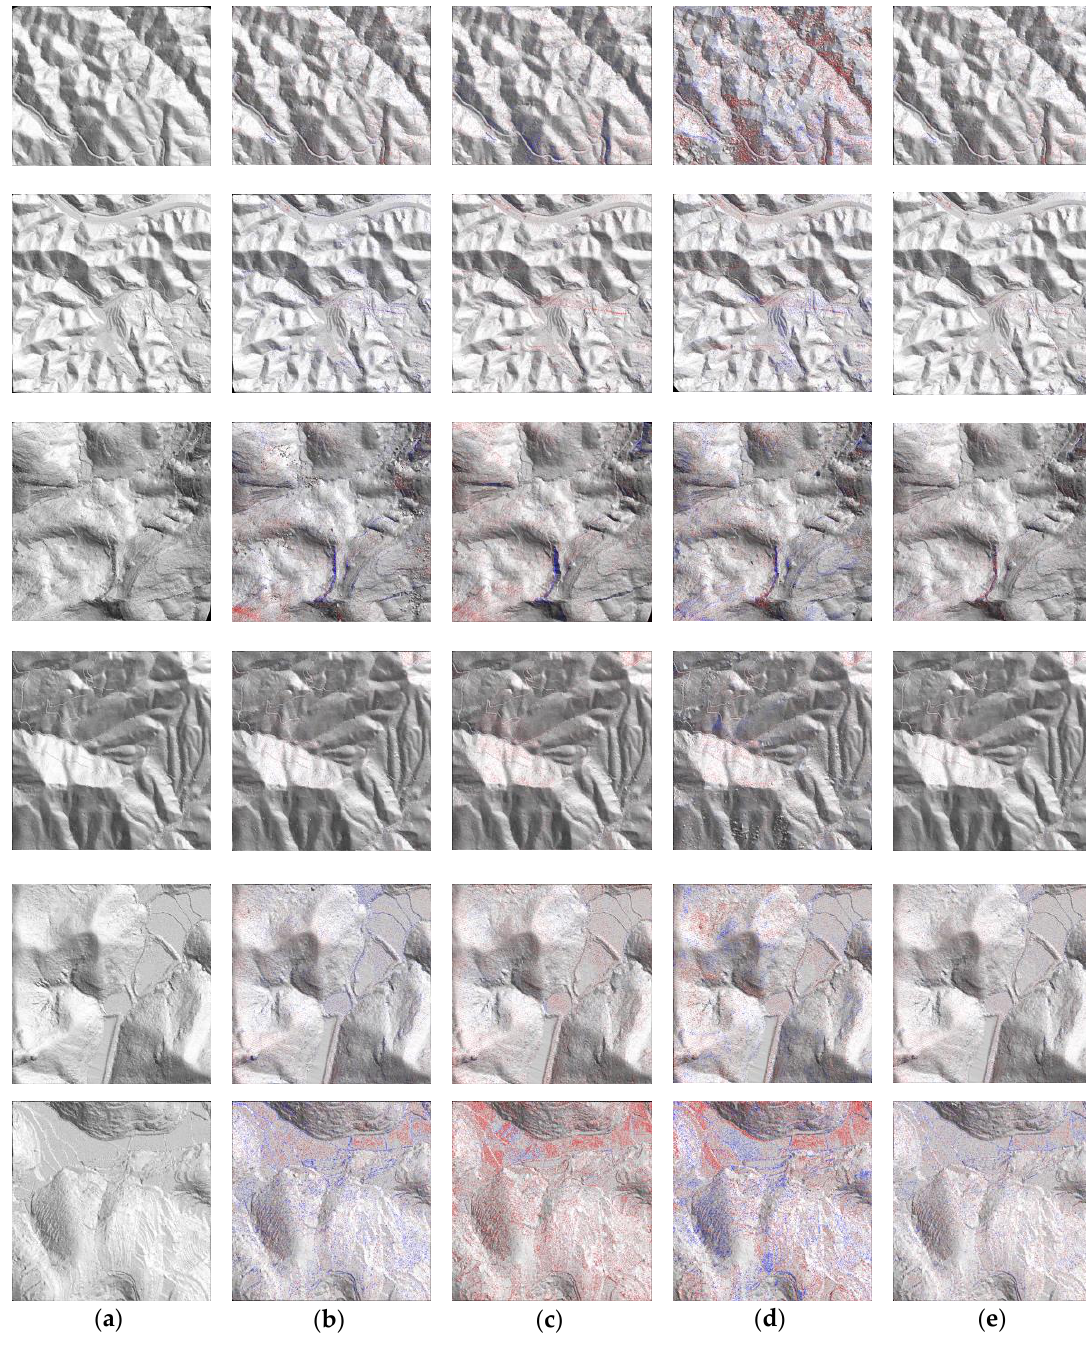
Figure 12. Comparison of proposed network with DGCNN, SparseConvNet, and DCNN regarding DEM details. ( a ) Ground truth triangulated irregular network (TIN)-rendered gray images of evaluated data, and TIN-rendered DEM extracted from the results of filtration by ( b ) DGCNN, ( c ) SparseConvNet, ( d ) DCNN, and ( e ) proposed network. Red denotes accepted non-ground points, blue denotes rejected ground points.